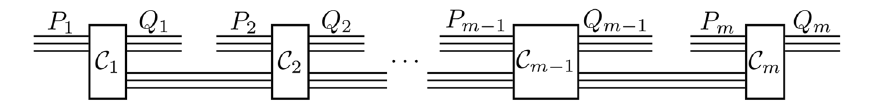
Fig. 2 Decomposition of a physical process into a sequence of m interactions. The inputs (outputs) of the processes are divided into m non- overlapping subsets. The i -th subset of the inputs (outputs) consists of the systems that enter (exit) the interaction at the i -th step (rectangular boxes in the picture). The wires connecting one interaction to the next represent intermediate systems that in this stage are not directly accessible to experiments. For example, a photon could enter the fi rst interaction, remain as an intermediate system between the fi rst and second interaction, and then exit the interaction region after the second interaction.